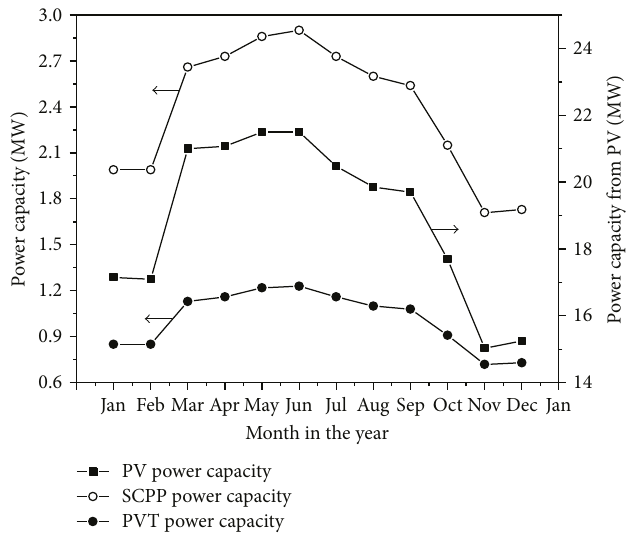
Figure 6: Power capacity of the PV, SCPP, and